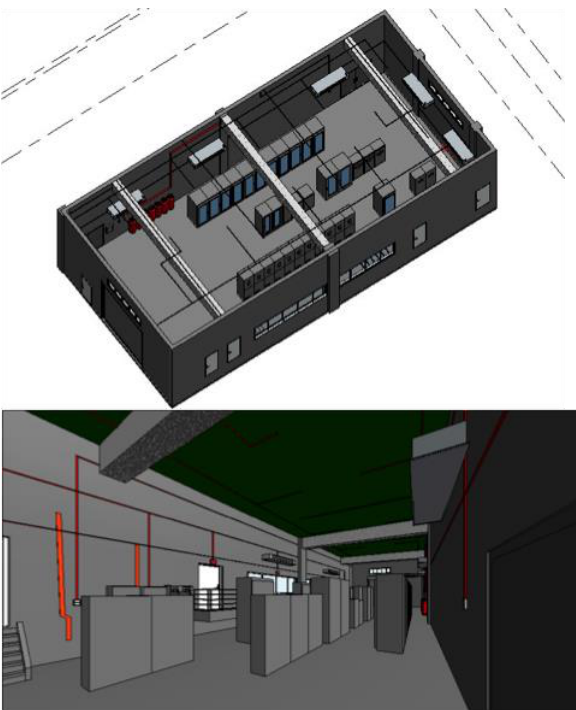
Figure 7: 3D model of 132/22KV Control and Relay Room